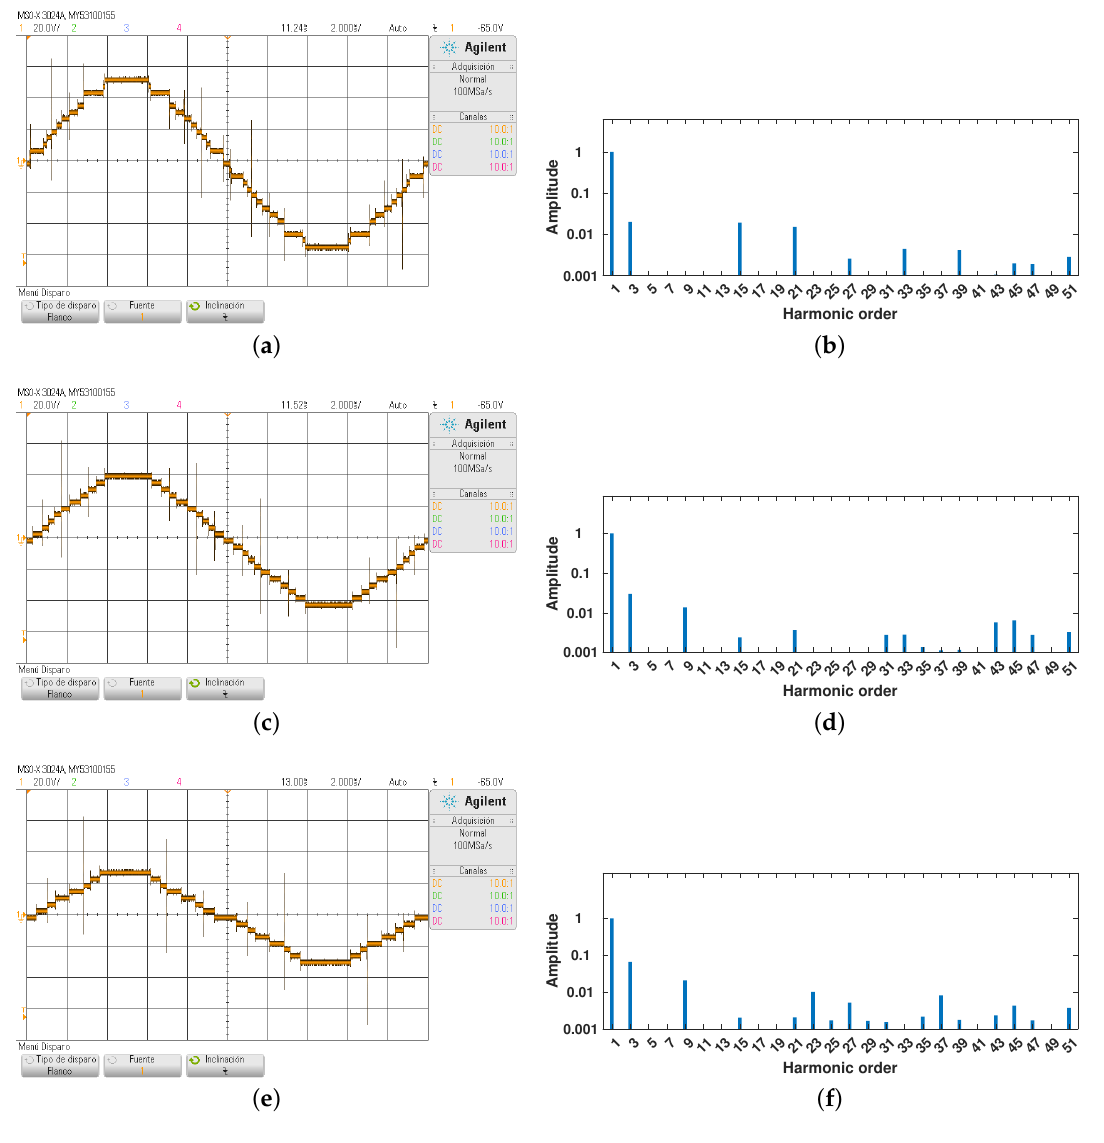
Figure 12. Waveforms for experimental implementation for different M values. ( a ) Output voltage for M = 1, ( b ) harmonic spectrum for M = 1, ( c ) output voltage for M = 0.75, ( d ) harmonic spectrum for M = 0.75, ( e ) output voltage for M = 0.5, and ( f ) harmonic spectrum for M =